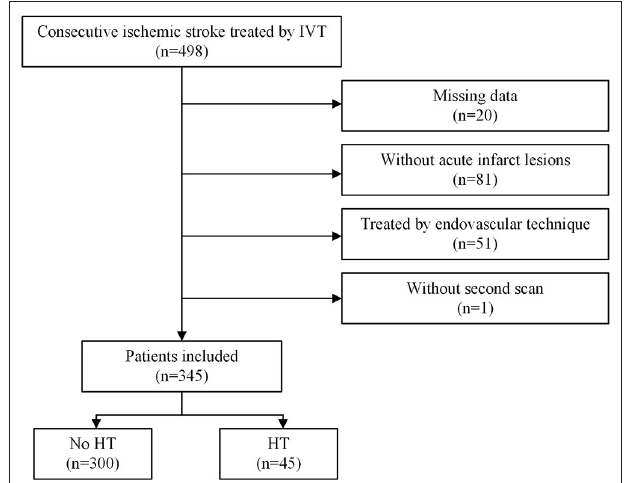
FIGURE 1 | Flow chart illustrating patient selection. IVT indicates introvenous thrombolysis. HT indicates hemorrhage transformation. IVT, intravenous thrombolysis; HT, hemorrhage